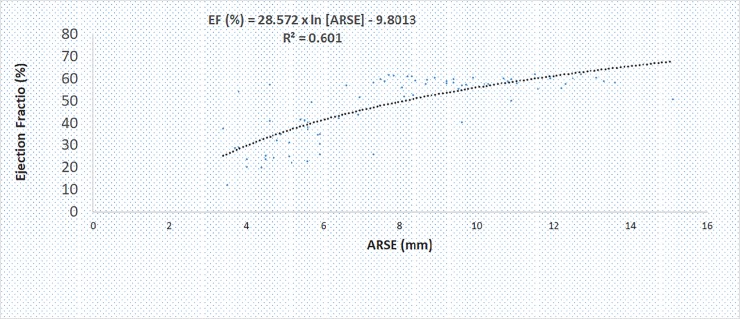
Scatter plot of ARSE (mm) versus LE ejection fraction (Simpson).